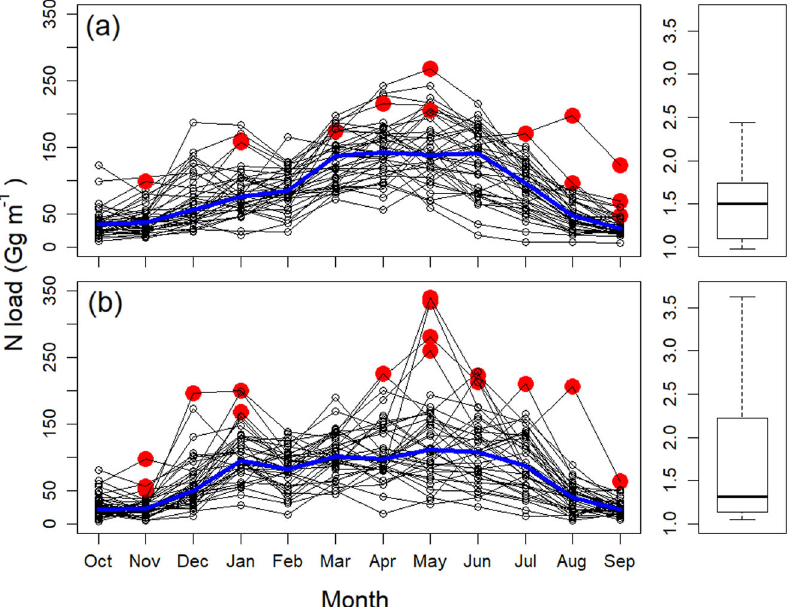
Fig. 4 Monthly N loads from the Mississippi-Atchafalaya River Basin to the Gulf of Mexico. ( a ) The sum of N load measured at St. Francisville (7373420) and Melville (7381495) during 1980 – 2017 as estimated by USGS LOADEST. ( b ) DLEM estimated N load during 1980 – 2017. Red circles are months with extreme river fl ows and the blue line is the median value for each month derived from the 38-year pro fi le. The right panel indicates the deviations of N loads in the extreme fl ow months from monthly median values, with the black line and box indicating the mean and the 1st and 3rd quantile and the upper and lower whiskers indicating the maximum and